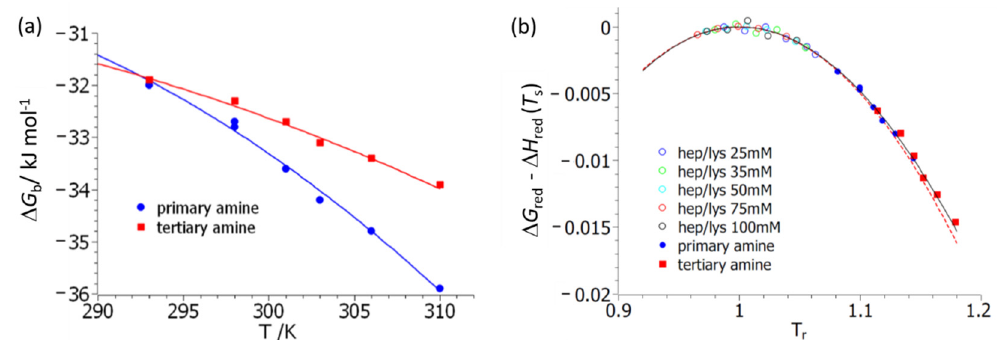
Figure 3. Analysis of the free energy, ∆ G b , of complex formation between BSA and polymers 3 (primary amine) and 4 (tertiary amine), respectively, according to Equations (7) and (10a). ( a ) Fits of Equation (7) to experimental data. The parameters obtained from this fit are gathered in Table 1. ( b ) Analysis of the data in terms of the master curve Equation (10a). The reduced free energy of binding, ∆ G red , is plotted against the reduced temperature, T r = T/T s . The solid line denotes the exact results, whereas the dashed line displays the series expansion according to Equation (11). The hollow points refer to the data obtained for the system heparin/lysozyme studied in [33].